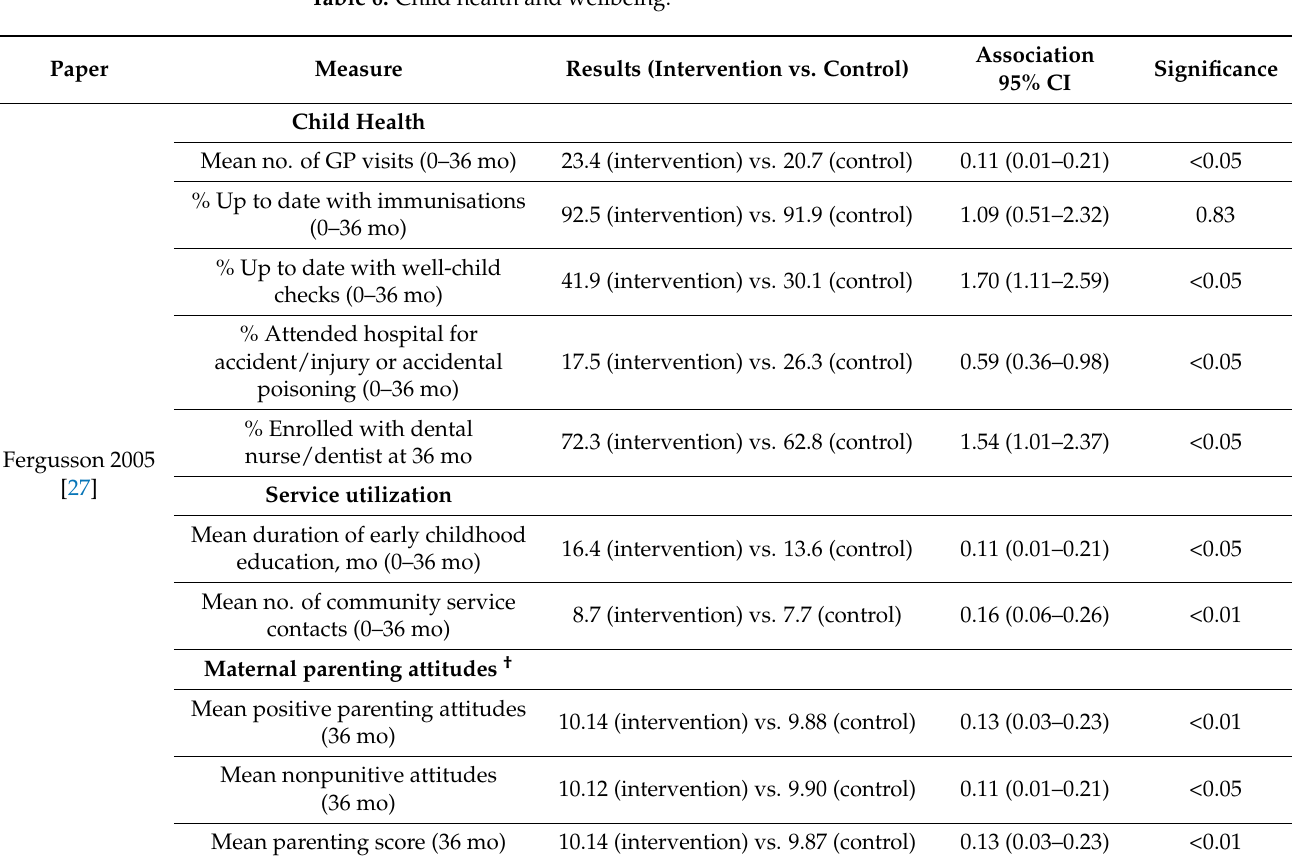
Table 6. Child health and